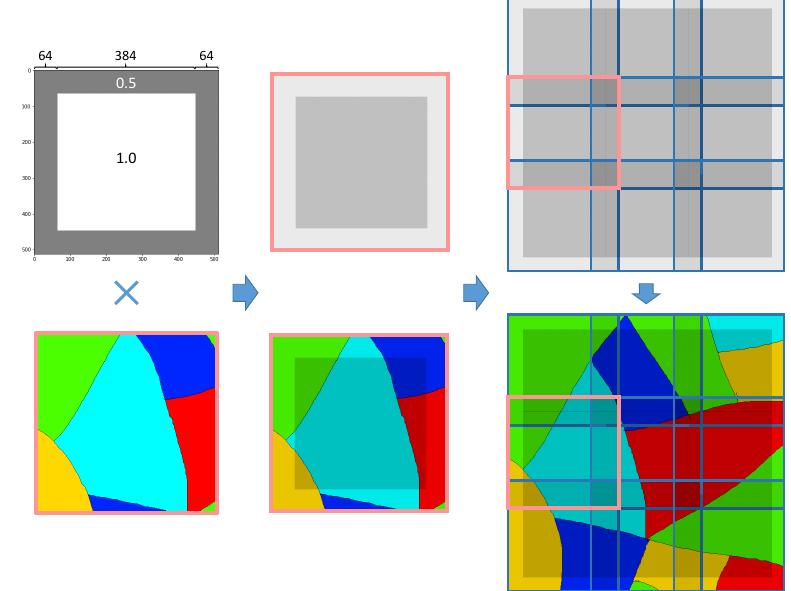
Figure 8. An illustration of decision fusion post-processing via mask-weighted